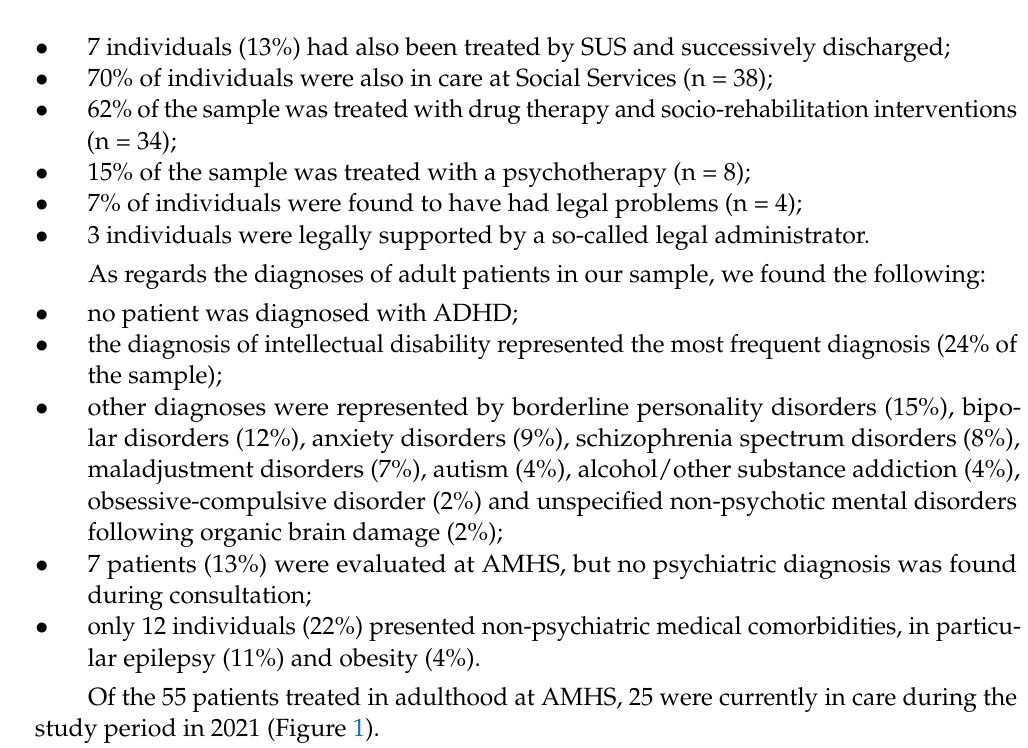
Table 2. Variables of subjects (n = 7) divided by DIVA 2.0 score.